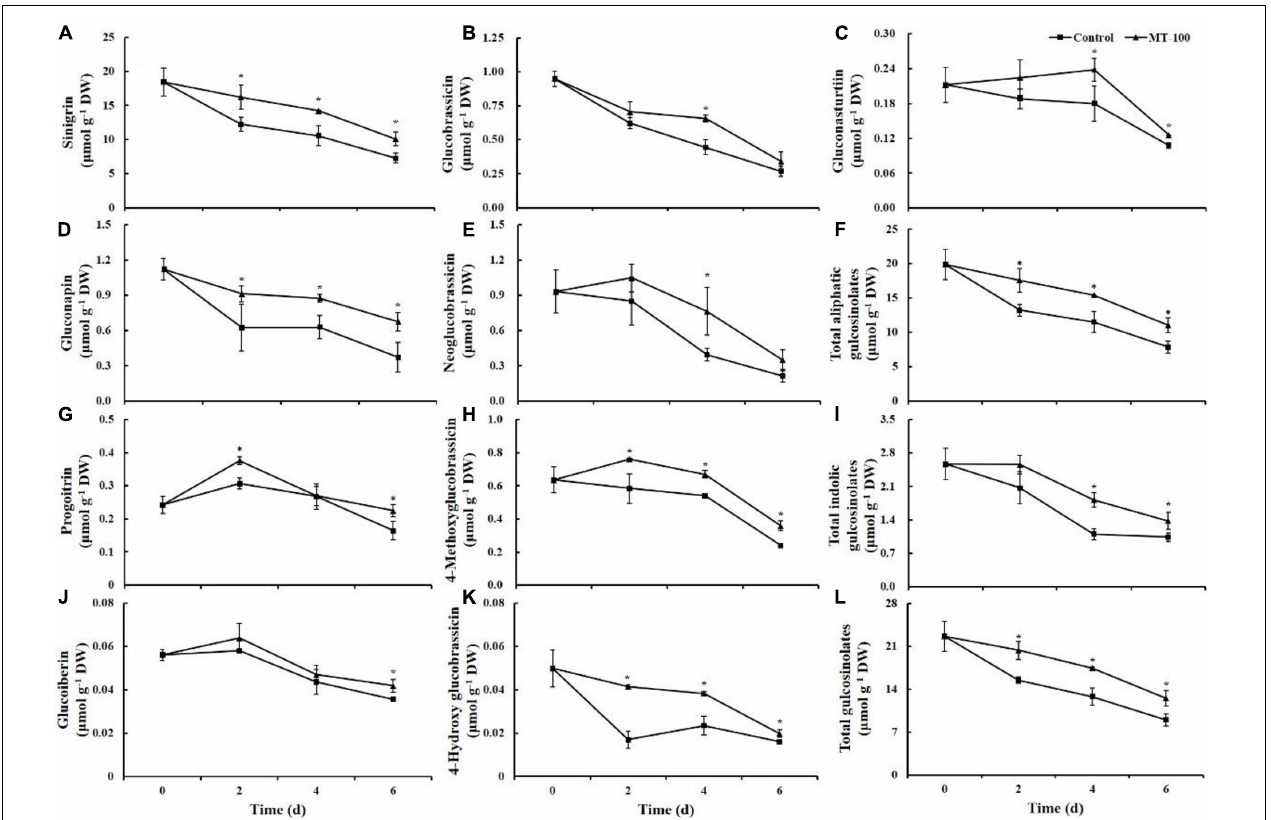
FIGURE 5 | Glucosinolate content of 100 µ mol L − 1 melatonin treated lateral buds of baby mustard during storage at 20 ◦ C. (A) Sinigrin; (B) glucobrassicin; (C) gluconasturtiin; (D) gluconapin; (E) neoglucobrassicin; (F) total aliphatic gulcosinolates; (G) progoitrin; (H) 4-methoxyglucobrassicin; (I) total indolic gulcosinolates;